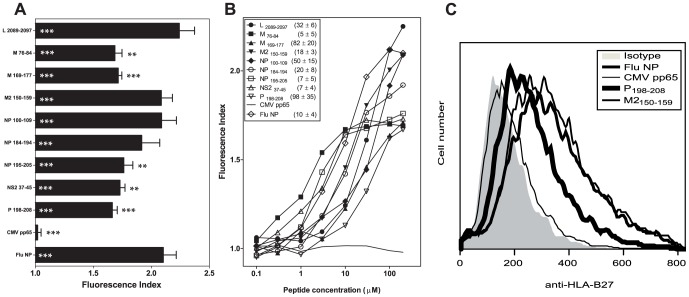
HLA-B*2705 stabilization with synthetic HRSV ligands.The stability of HLA-B*2705/peptide complexes on the cell surface of transfected RMA-S cells was measured through flow cytometry. Panel A: The indicated peptides were used at 200 µM. The CMV pp65 and Flu NP peptides were used as negative and positive controls, respectively. The mAb ME1 was used for staining. The results, calculated as fluorescence indexes, show the means ± SD of 4-5 independent experiments. Significant P values (***, p<0.001; **, p<0.01; *, p<0.05) versus negative or positive peptide controls are represented as white or black asterisks, respectively. Panel B: The titration curves for the indicated synthetic peptides with HLA-B*2705 are depicted. The results show the mean values obtained from three or four independent experiments. The calculated EC50 values (µM) (means ± SD) are shown in the legend of panel B. A representative experiment is depicted in panel C.